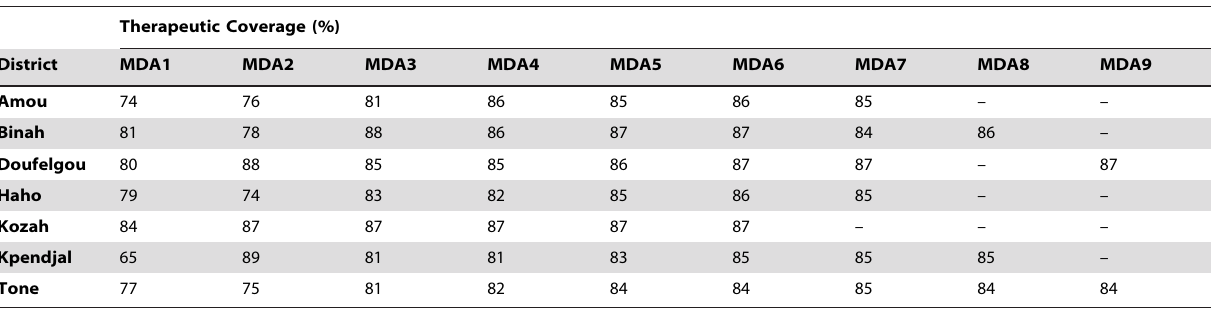
Table 1. Reported coverage for MDA in endemic districts of Togo (denominator= total